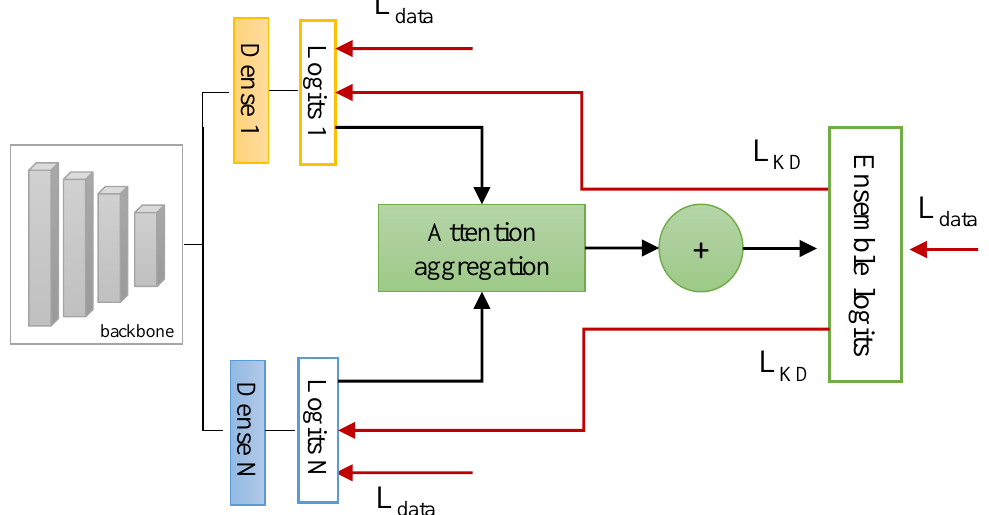
Figure 3. Transfer learning setup: The peer student networks share the same “frozen” backbone, initialized with ImageNet